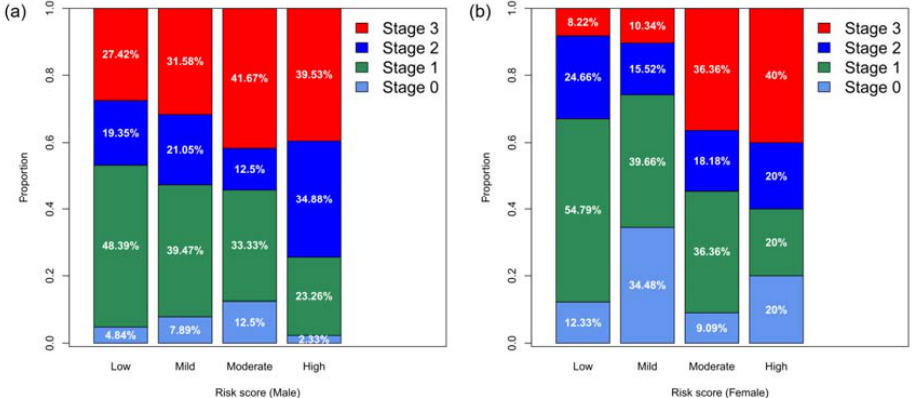
levels of risk (male) is illustrated. The risk score is positively correlated to the cancer stage, namely the proportion of advanced cancer stage increases in the higher risk score categories. ( b ) Characteristics for di ff erent levels of risk. The distribution of stages of cancers for di ff erent levels of risk (female) is illustrated. The risk score is positively correlated to the cancer stage, namely the proportion of advanced cancer stage increases in the higher risk score